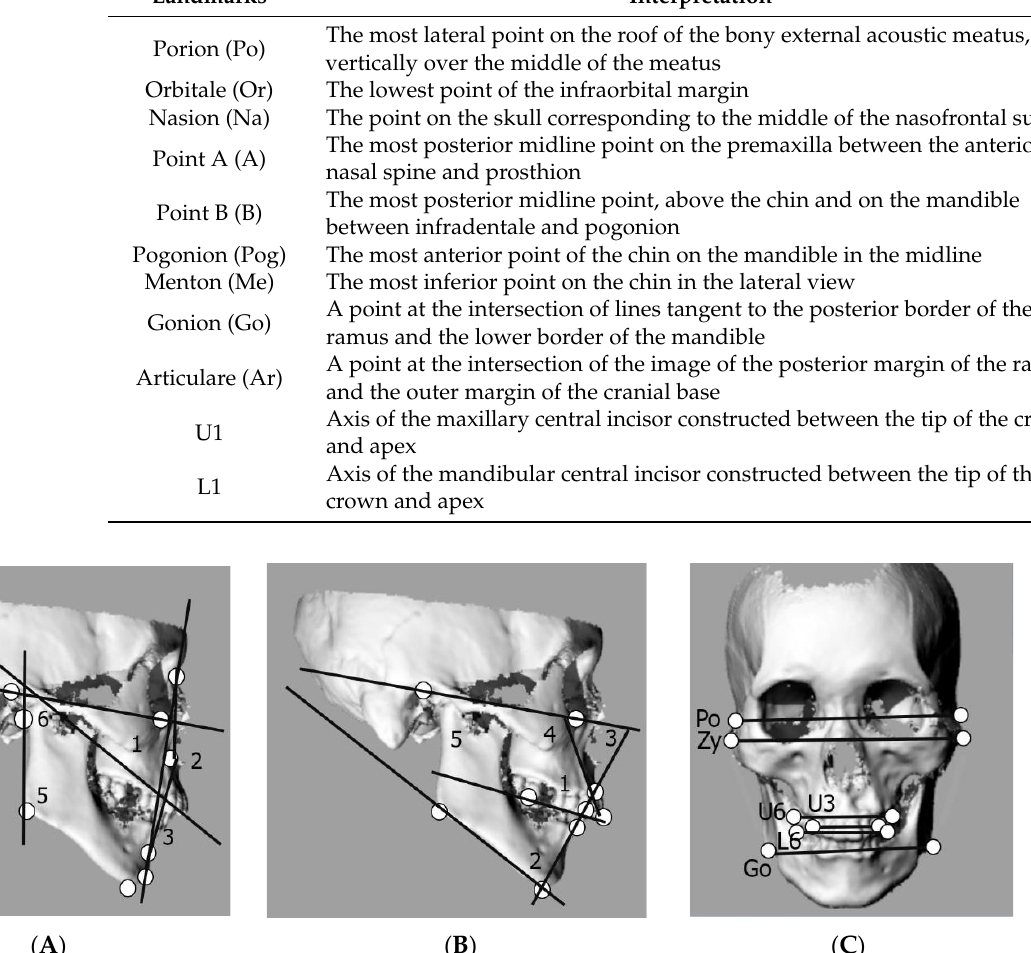
Table 1. Landmarks for the 3D analysis.